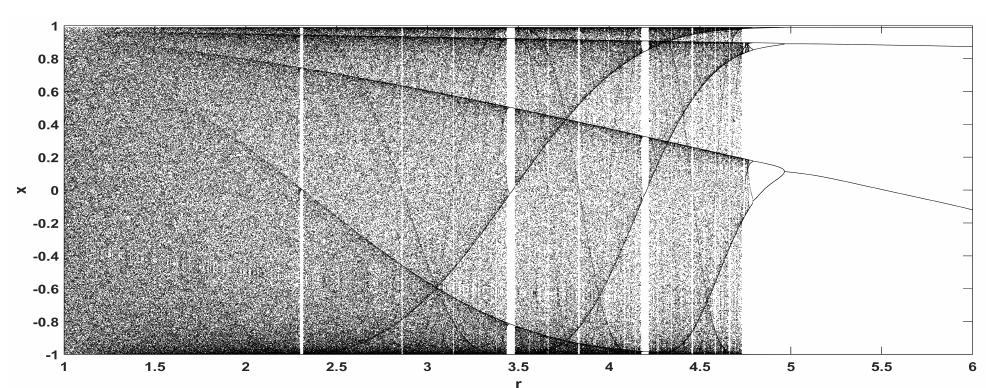
Figure 3. Bifurcation diagram with respect to parameter r , for a = 1, b =